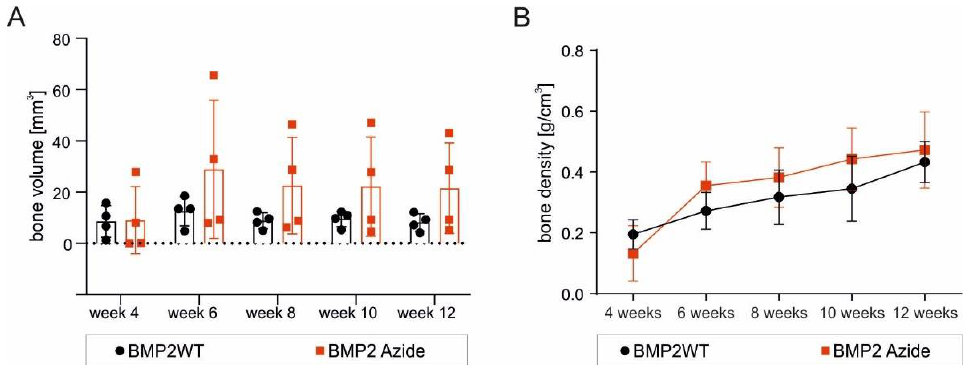
Figure 5. Evaluation of bone volume and bone density. Graphs show a micro-CT evaluation of ( A ) ectopic bone volume and ( B ) bone density over 12 weeks. n = 4. Statistical analysis was performed using non-parametric Mann–Whitney test . No significance was determined.